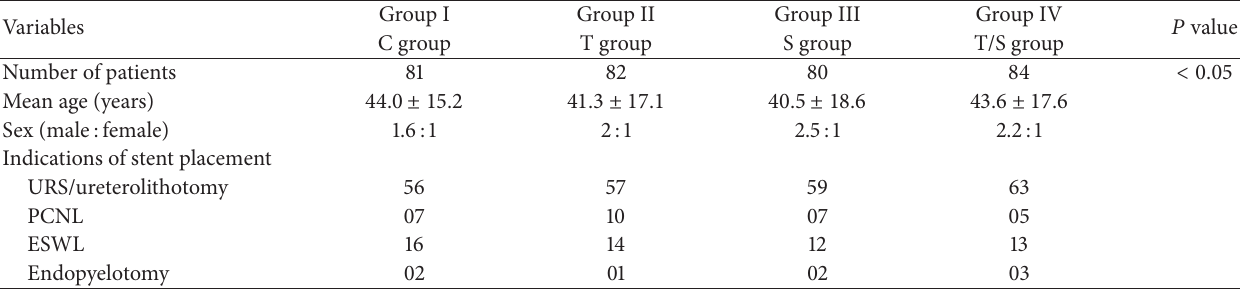
Table 1: Basic characteristics of studied patients.